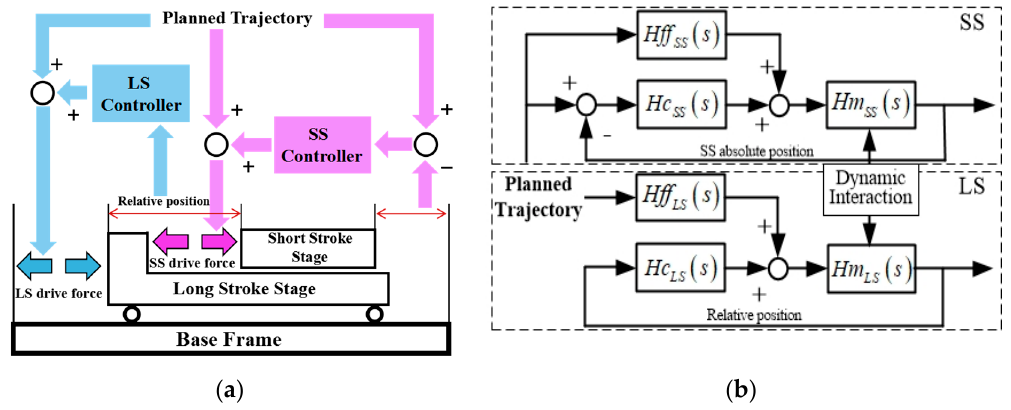
Figure 2. ( a ) Schematic and ( b ) control loops of control system in the Y direction.